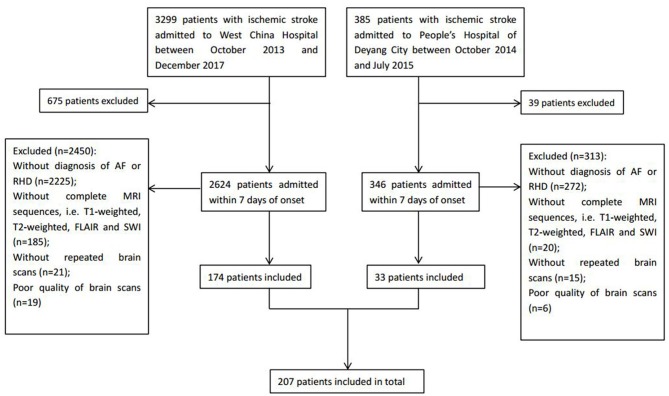
Flowchart of patient enrollment.